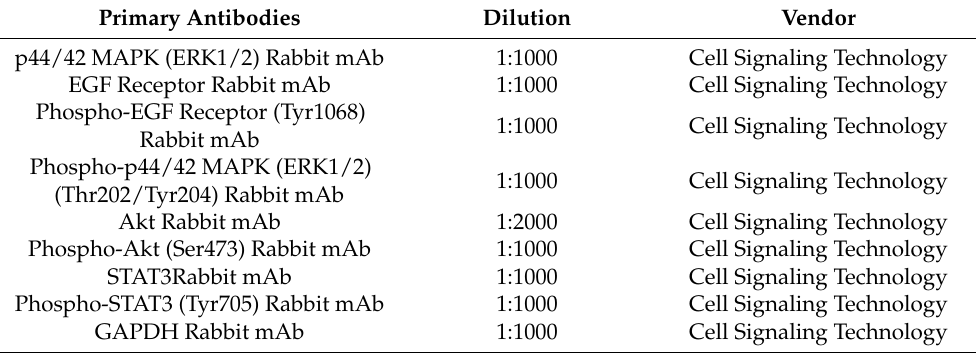
Table 1. List of primary antibodies used for Western